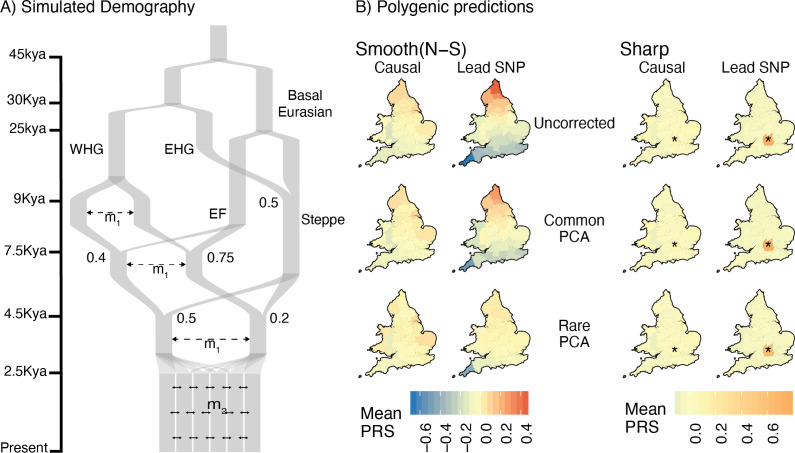
Residual stratification in polygenic scores under a complex demographic model, geographic structure representing England and Wales, and non-uniform sampling.(A) Illustration of the simulated demography. (B) Maps depicting the spatial distribution of residual polygenic scores, as in Figure 4, averaged across 20 simulations of the phenotype. Columns: ‘Smooth’ and ‘Sharp’ refer to environmental effects and ‘Causal‘ and ‘Lead SNP’ refer to sets of variants that were used to construct polygenic scores. Rows: Different methods of correction for population structure. WHG and EHG: Western and Eastern Hunter Gatherers; EF: Early Farmers.